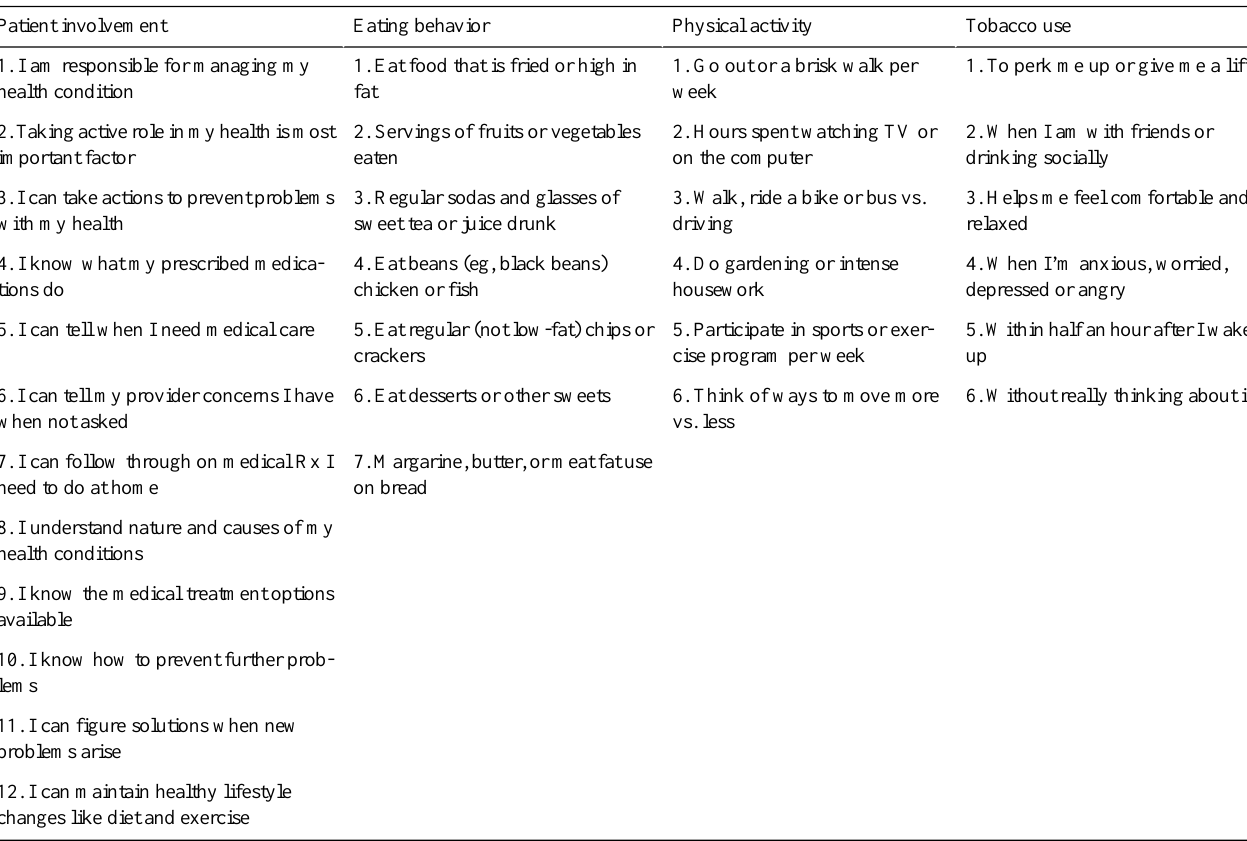
Table 1. Health behavior assessment questions on the iPod